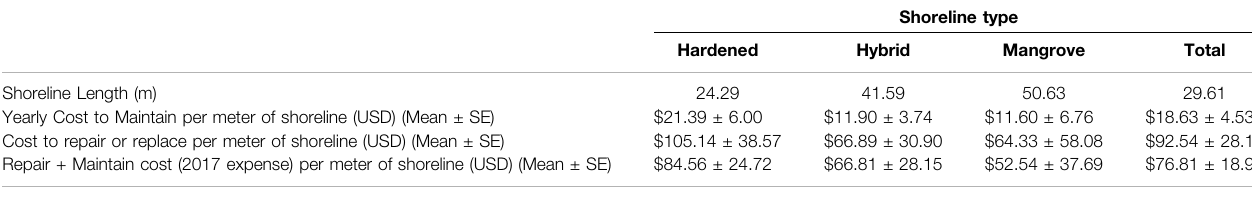
TABLE3| Reportedcostsofmaintainingandrepairingparcel-levelshorelinespermeter.The fi rstrowinthetabledisplays theaverageparcel-levelshorelinelengthinmeters for each category of shoreline type. Next row is the average (± SE) per meter annual maintenance cost of parcel-level shoreline for each category of shoreline type reported in US dollars. Next row is the average (± SE) per meter cost torepair or replace parcel-level shorelines for each category of shoreline type. Finally, the last row isthe combination of these two costs per meter for each shoreline type.